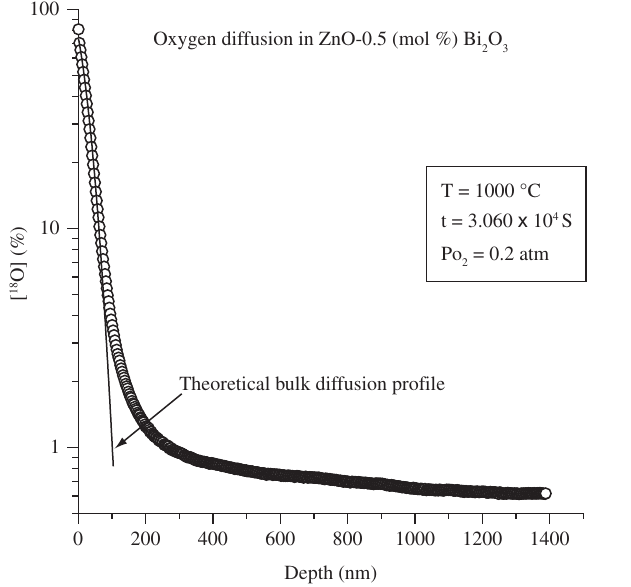
Figure 2. Oxygen diffusion profile in ZnO-0.5 mol % Bi at 1000 °C.